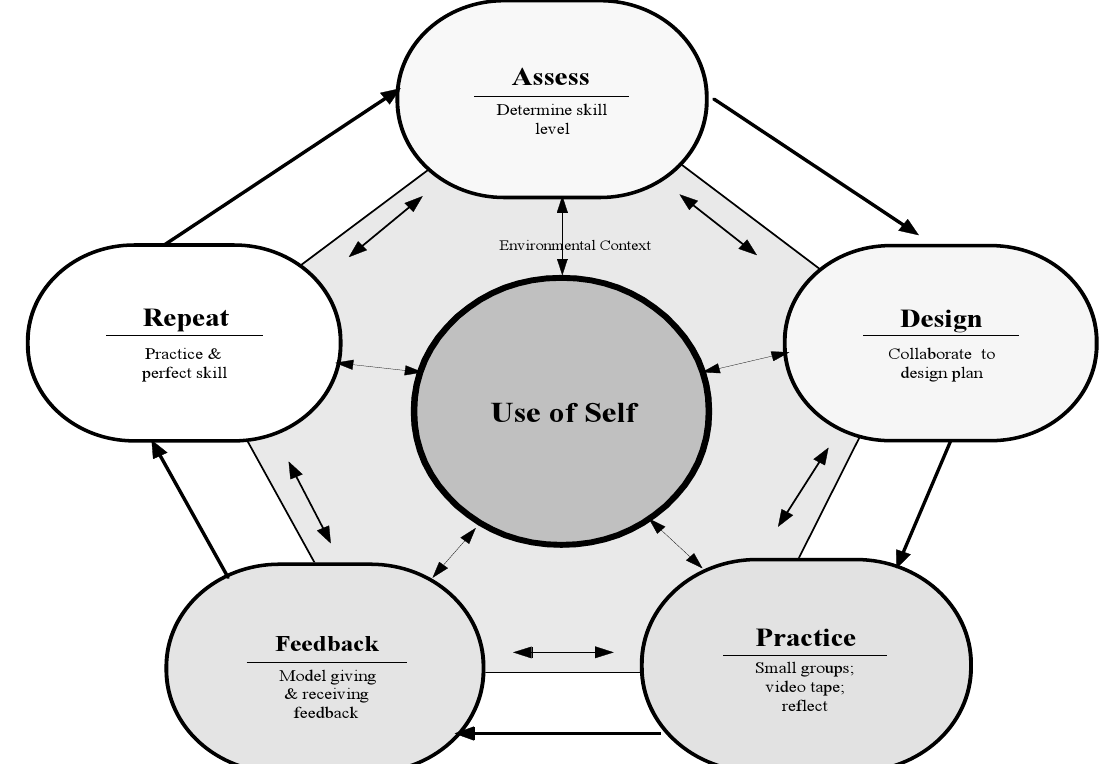
Figure 3. Skills Development 5-Cycle